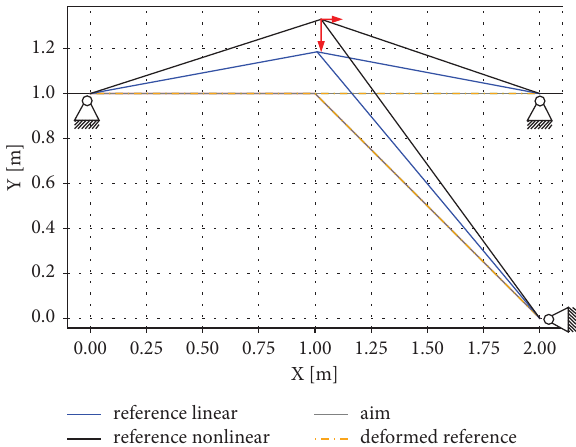
Figure 5: Unknown and known confguration of a 3-bar structure. Te red arrows demonstrate the force